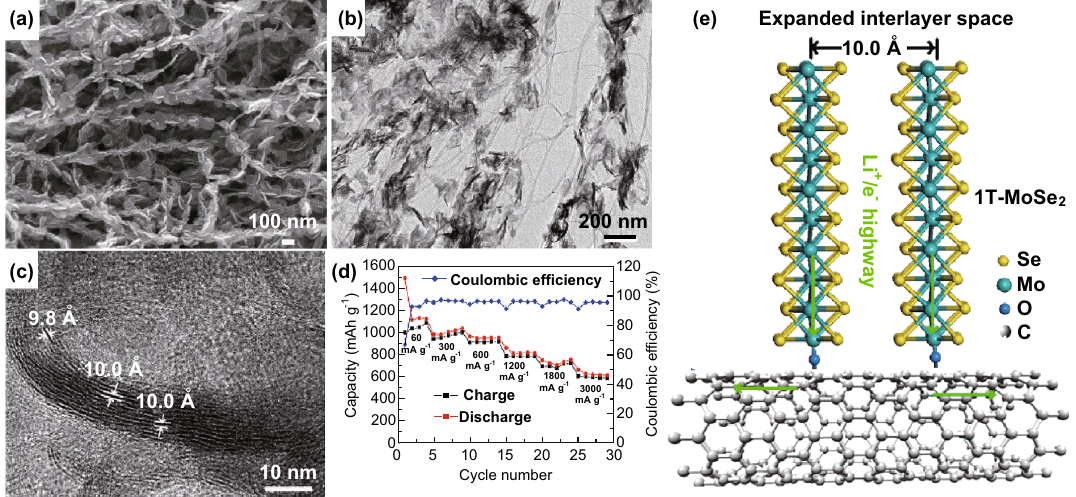
Fig. 6 3D architectures based on 2D MoSe 2 nanoflakes on 1D SWCNT skeleton for LIBs. a SEM image and b TEM image of the hybrids, revealing MoSe 2 nanoflakes anchored intimately on the surface of a SWCNT bundle. c Corresponding HRTEM image showing enlarged interlayer distance of 10.0 A˚ . d Rate performance of 1T-MoSe 2 /SWCNTs hybrids. e Schematic illustration showing the electrochemical process in 1T-MoSe 2 /SWCNT electrode. Reproduced with permission [100]. Copyright (cid:2) 2017, American Chemical